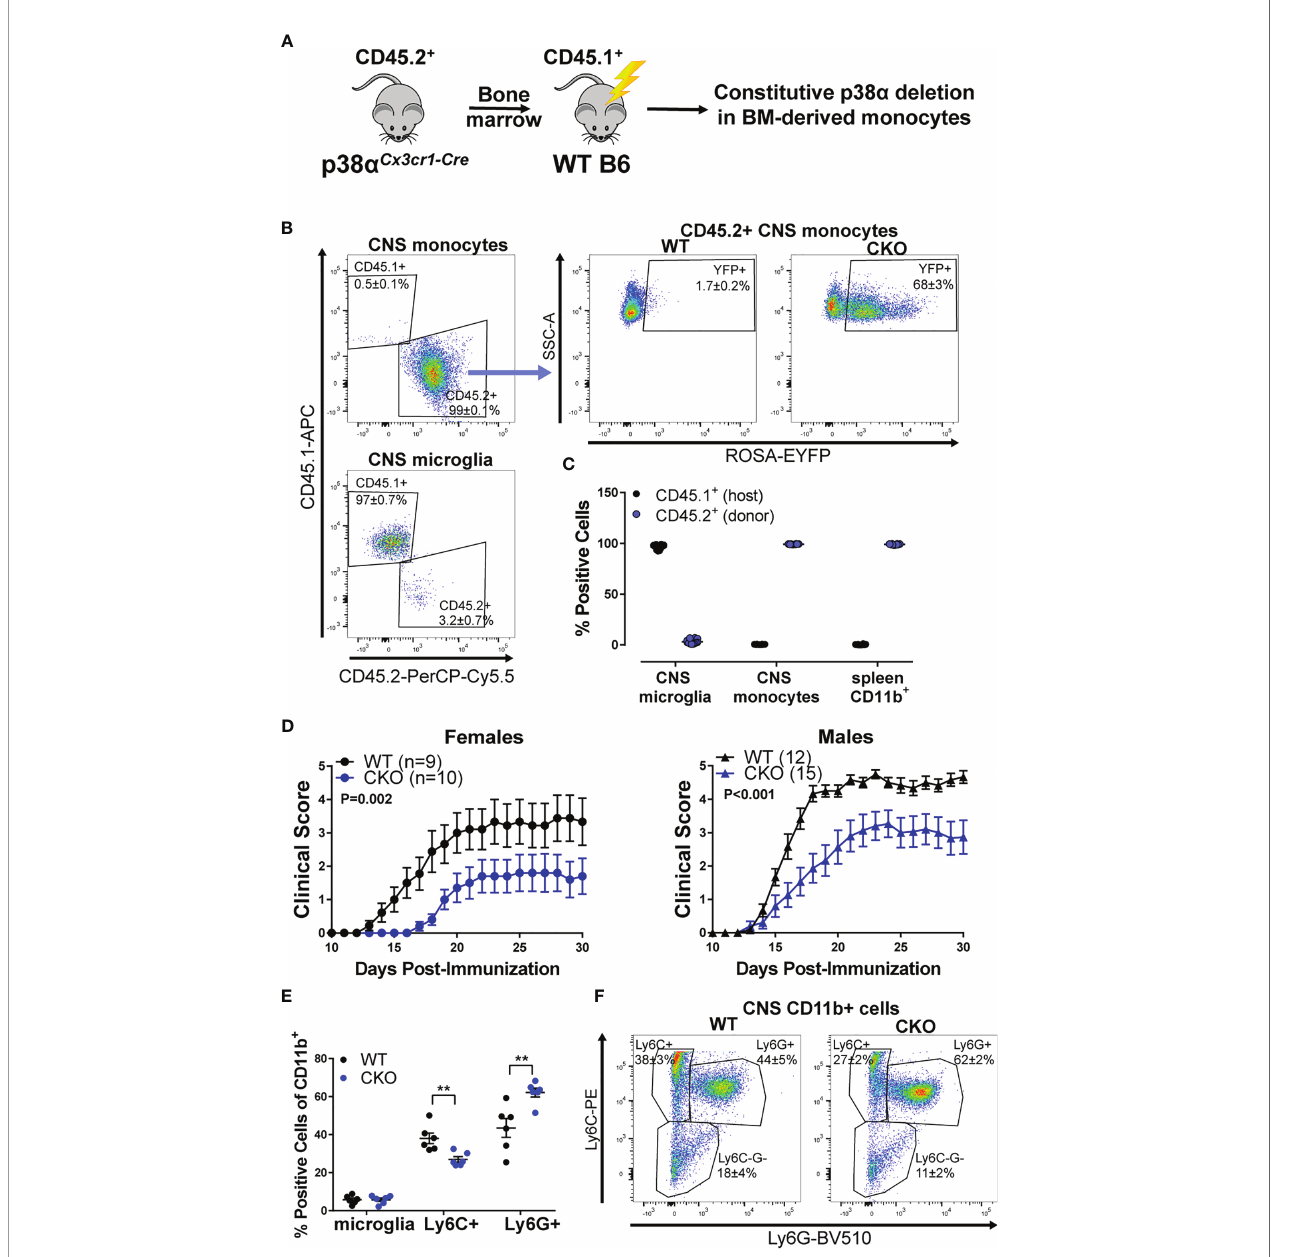
FIGURE 2 | Deletion of p38 a in BM-derived myeloid cells reduces EAE severity in female and male mice. Bone marrow chimeric mice were constructed by transplanting bone marrow from CD45.2 + donors (either p38 a CKO Cx3cr1 or WT littermate Cre-negative controls) to CD45.1 + WT recipients (see Materials